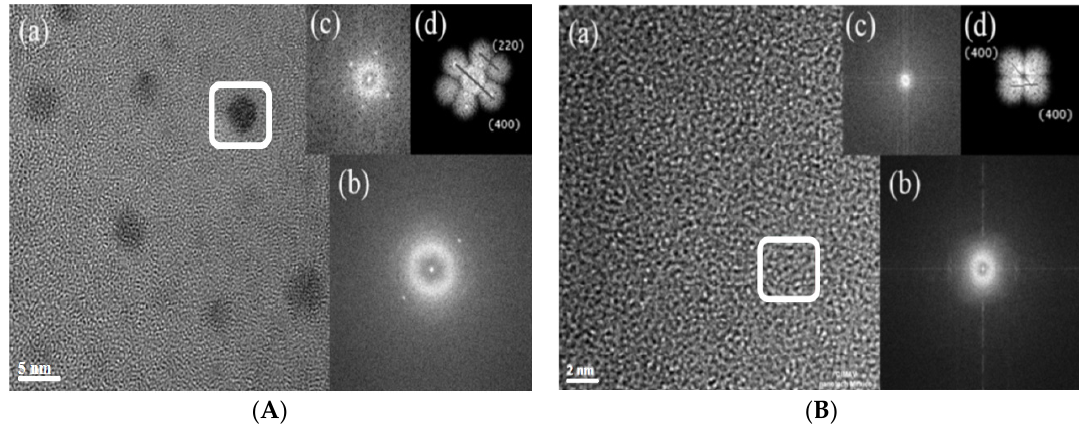
Figure 3. Cross ‐ section TEM images of embedded films with red ( A ) and blue ( B ) Si ‐ NCs, after thermal annealing at 1100 °C for 3 h in N 2 atmosphere. In both images, the white square marks the area of analysis where there is a Si ‐ NCs. The insets are: ( a ) the cross ‐ section TEM images; ( b ) FFT; ( c ) the specific pattern of the white square area; and ( d ) the electrons’ diffraction planes of the white square areas, for each image.